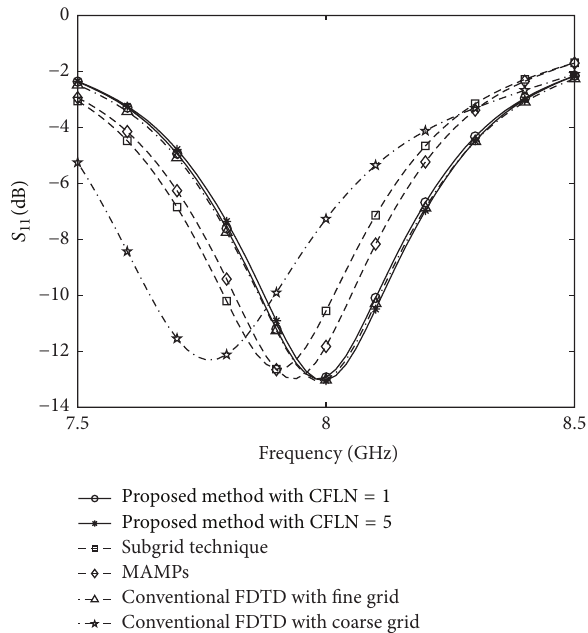
Figure 8: Return loss of the microstrip antenna using different methods.